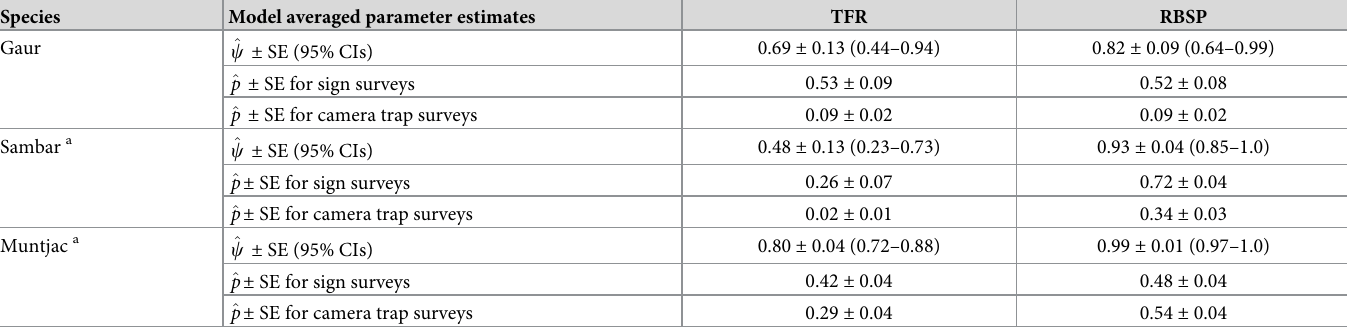
Table 2. Model averaged occupancy ( ^ c ) and detection probability ( ^ p ) estimates for ungulates in Temengor Forest Reserve (TFR) and Royal Belum State Park (RBSP). Species Model averaged parameter estimates TFR